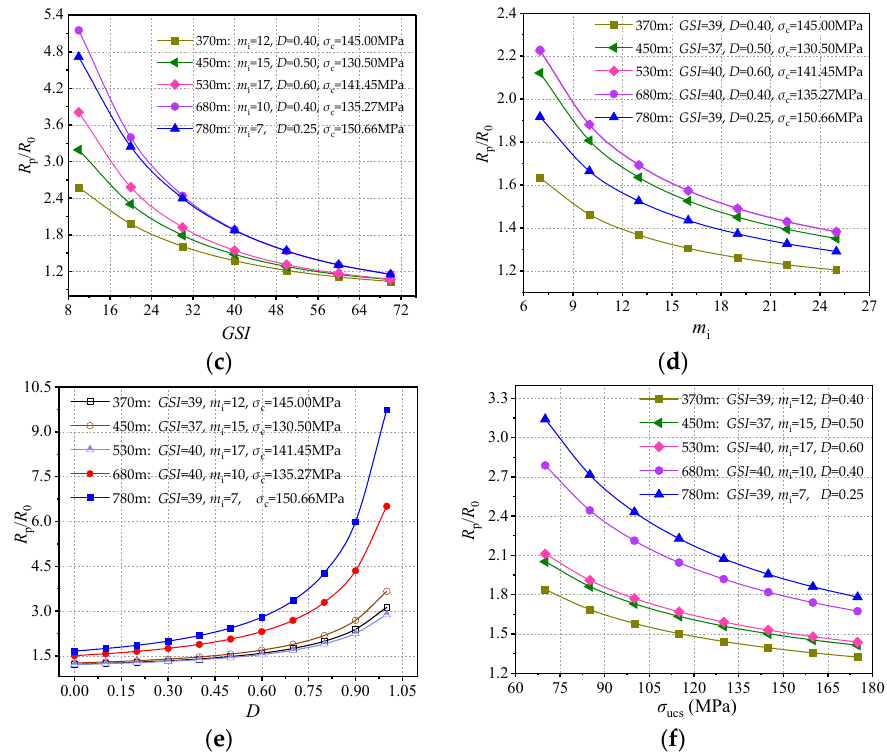
Figure 7. EDZ thickness variation with different rock mass parameters: ( a ) effect of c on R 0 / R p ; ( b ) effect of φ on R 0 / R p ; ( c ) effect of GSI on R 0 / R p ; ( d ) effect of m i on R 0 / R p ; ( e ) effect of D on R 0 / R p ; ( f ) effect of σ ucs on R 0 / R p .